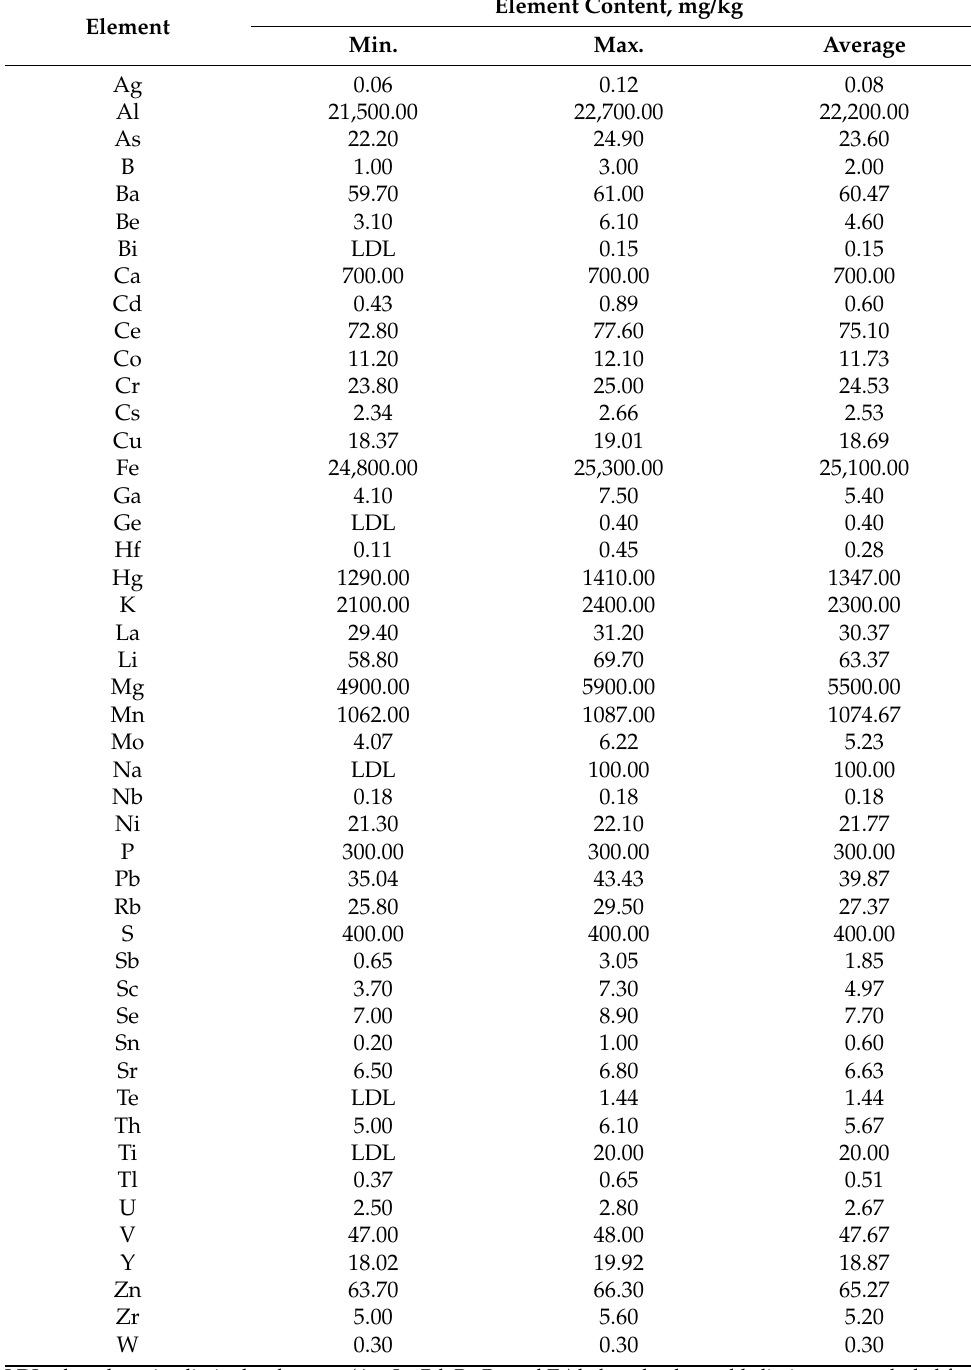
Table 1. Elemental content of mercury-contaminated soil